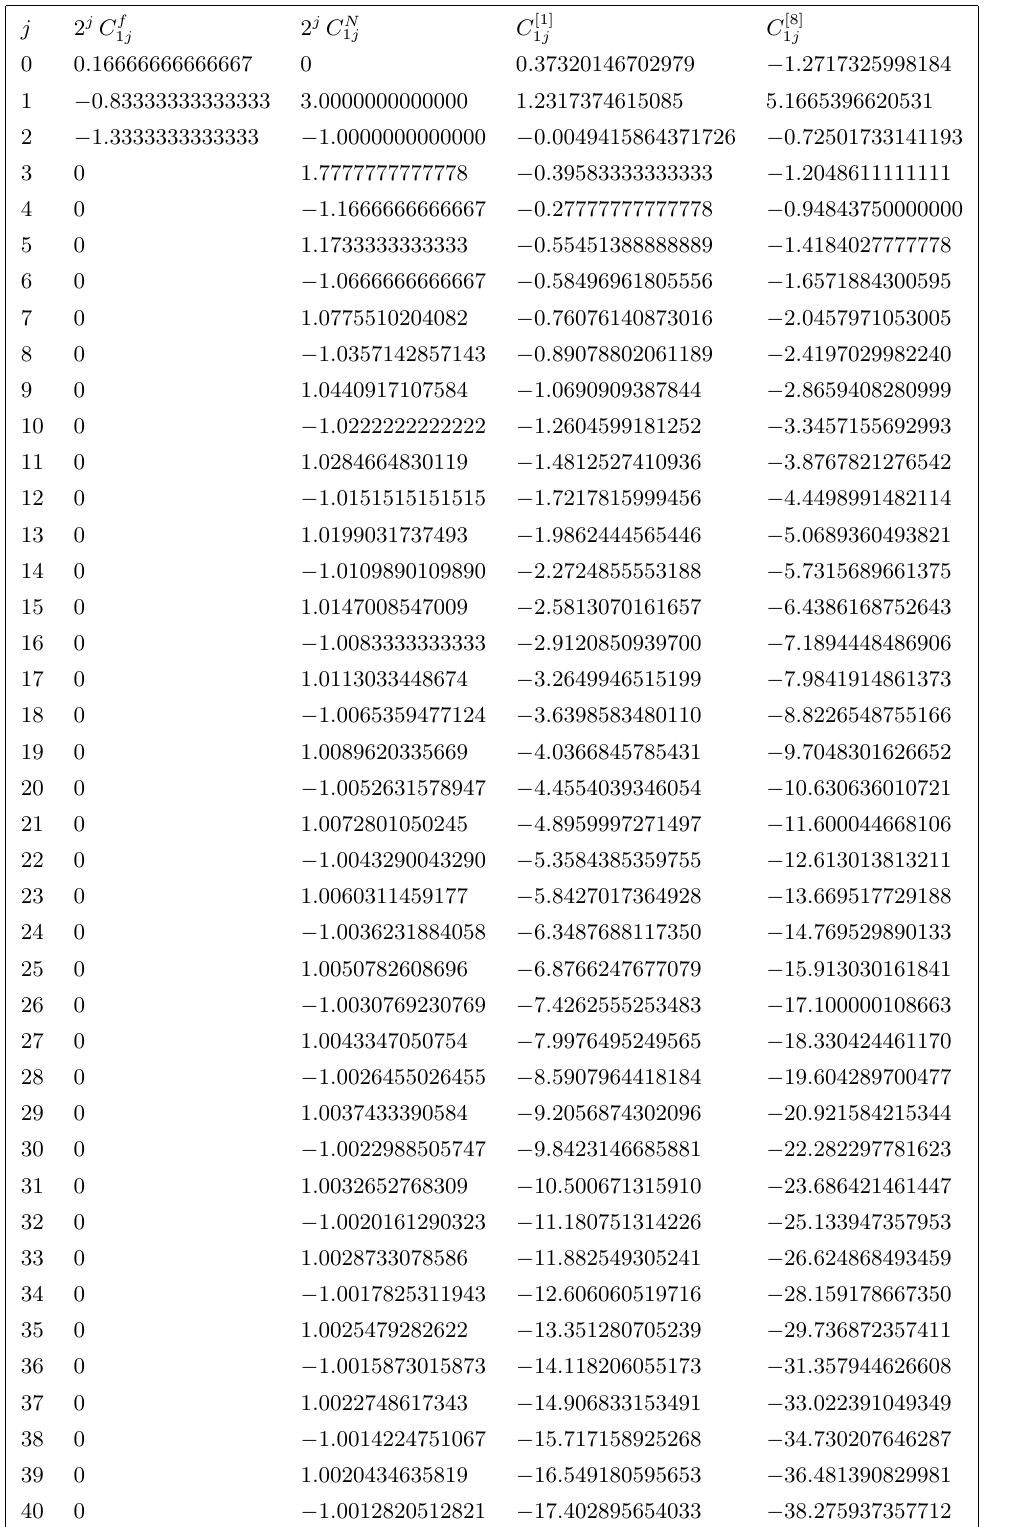
Table 9 . Coe(cid:14)cients of the term including ln 1 (1 (cid:0) z ) in the asymptotic expansion at z =